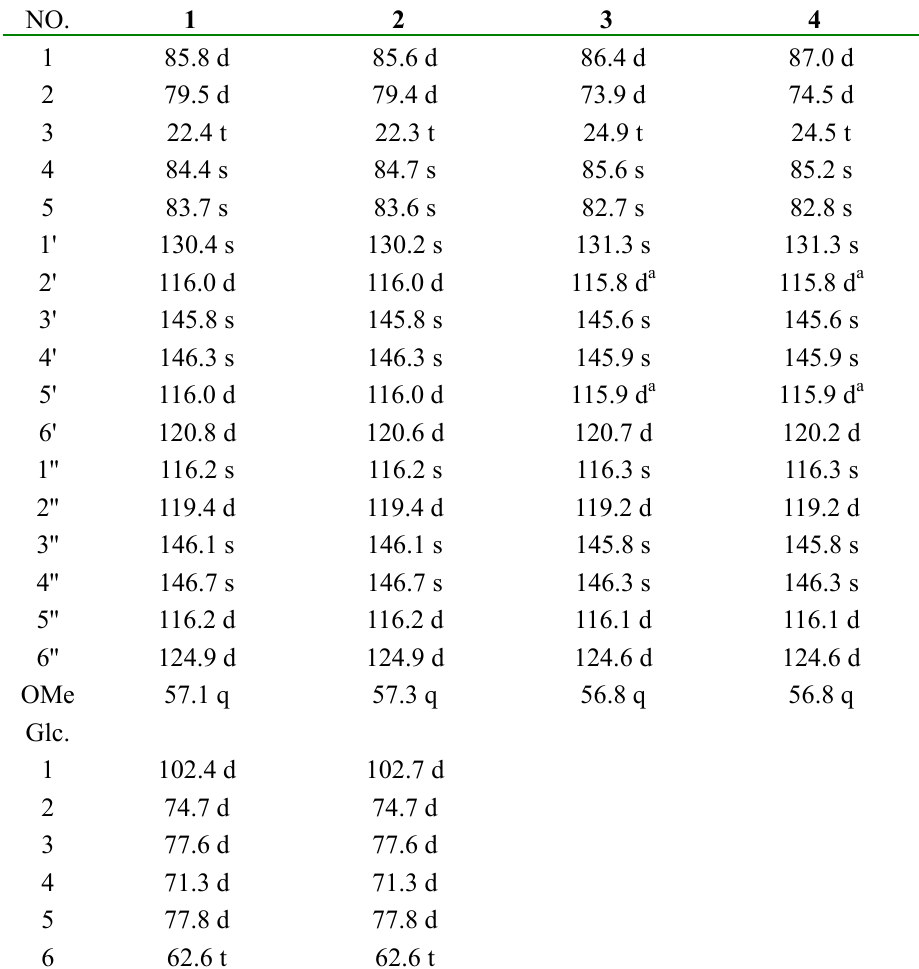
Table 2. 13 C-NMR (100 MHz, δ in ppm) data for compounds 1 - 4 in CD